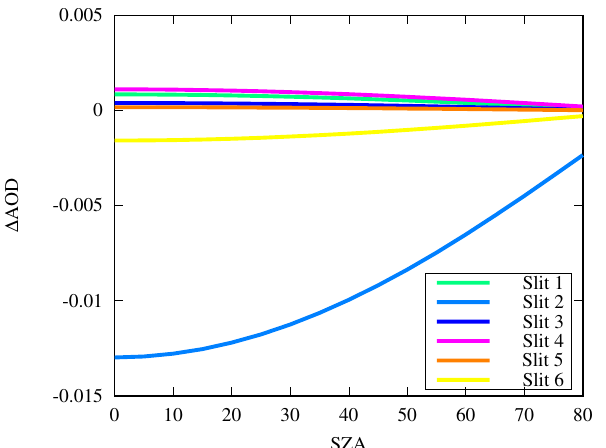
Figure 12. Simulated direct-sun spectrum convoluted to the Brewer bandwidth (slit 2). The dark-grey vertical line shows the central wavelength of Brewer measurements through the second slit, which is on the edge of a deep Fraunhofer line. The light-grey dashed lines represent the Brewer resolution at the second